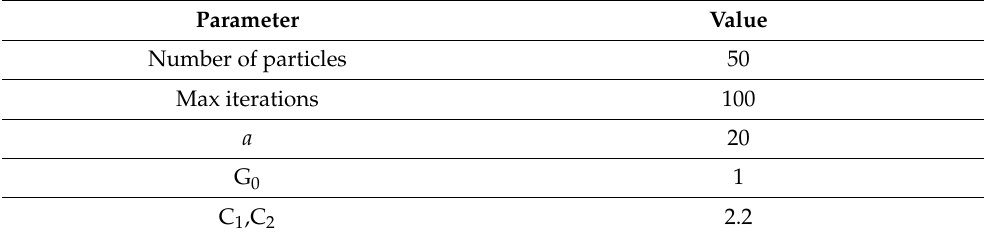
Table 3. Initial parameters for PSO-GSA.